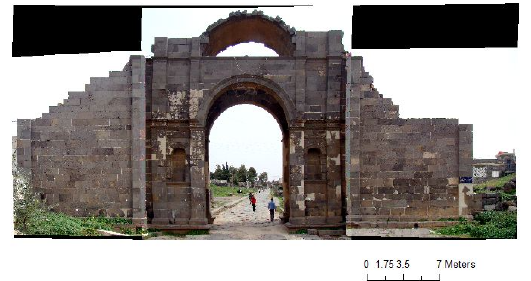
Figure 6. Photomosaic of the Western Gate using